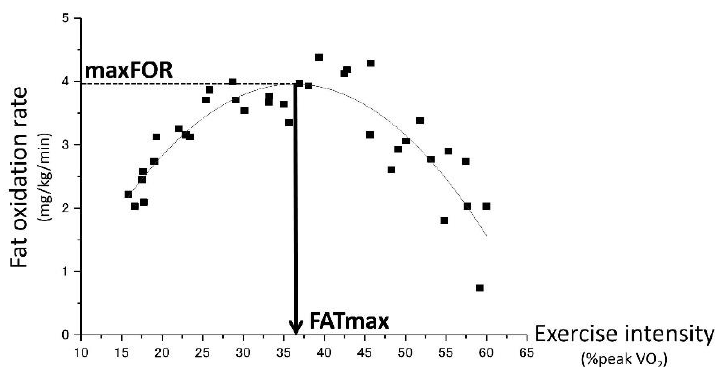
Figure 2. Estimating the maximum fat oxidation rate (maxFOR) and FATmax. For each subject, a quadratic polynomial curve was constructed by plotting all 1-min records on a graph with FOR (mg/kg/min) versus exercise intensity, which is represented by % peak oxygen uptake (VO 2 ). Curve fitting and peak analysis were conducted using software to determine the maxFOR during the incremental exercise test and FATmax, the exercise intensity that raises the maxFOR. Notes: FOR, fat oxidation rate; and VO 2 , oxygen consumption.